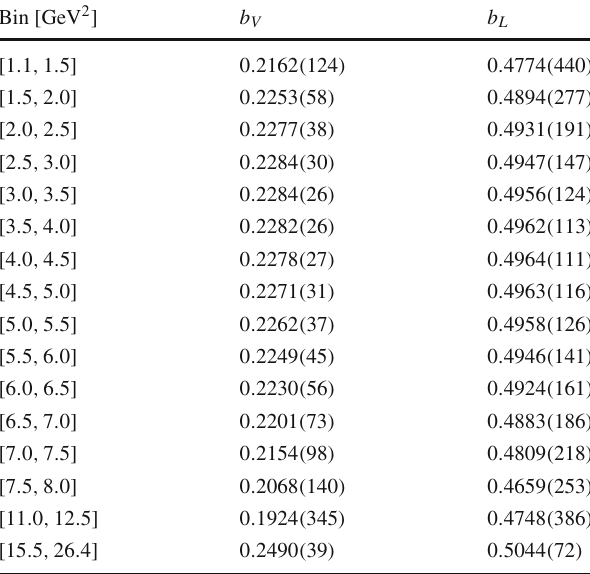
Table 3 Central values and uncertainties for the b V and b L parameters in all q 2 bins Bin [GeV 2 ] b